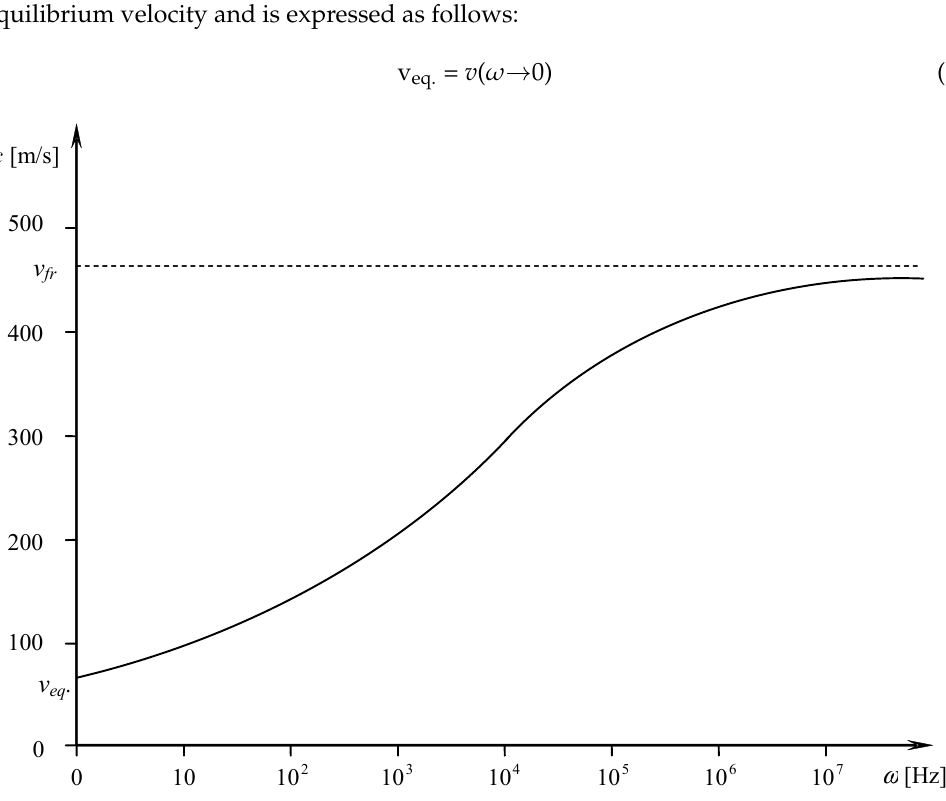
Figure 4. Pressure wave velocity as a function of frequency for conventional channels, Moody diagram [11,12,21,22].